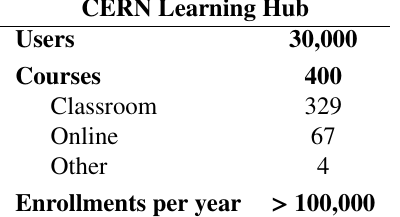
Table 1. Learning Hub key figures, measured as number of users accessing the platform, number of courses available (shown also by learning type) and number of enrollments per